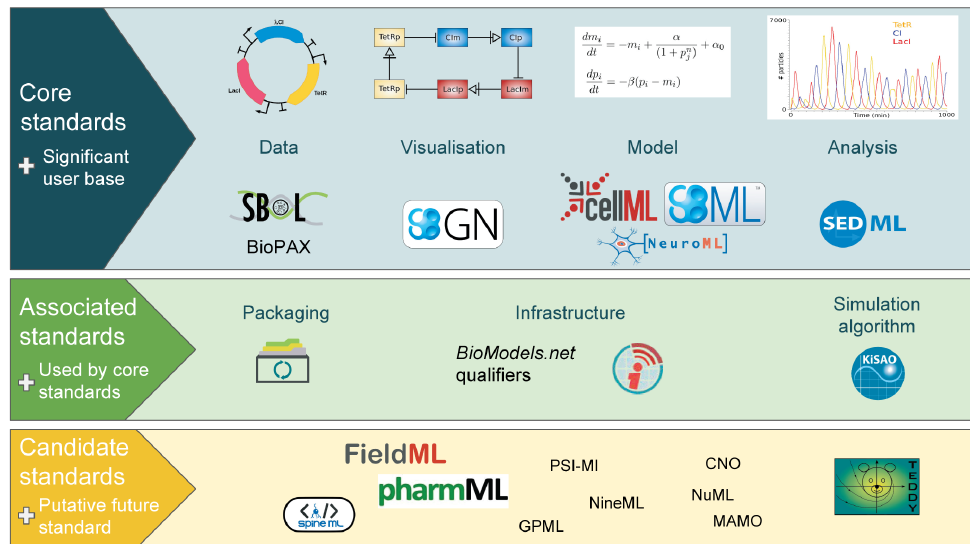
Figure 1: Overview of standards and associated efforts in Systems and Synthetic Biology provided by COMBINE (from